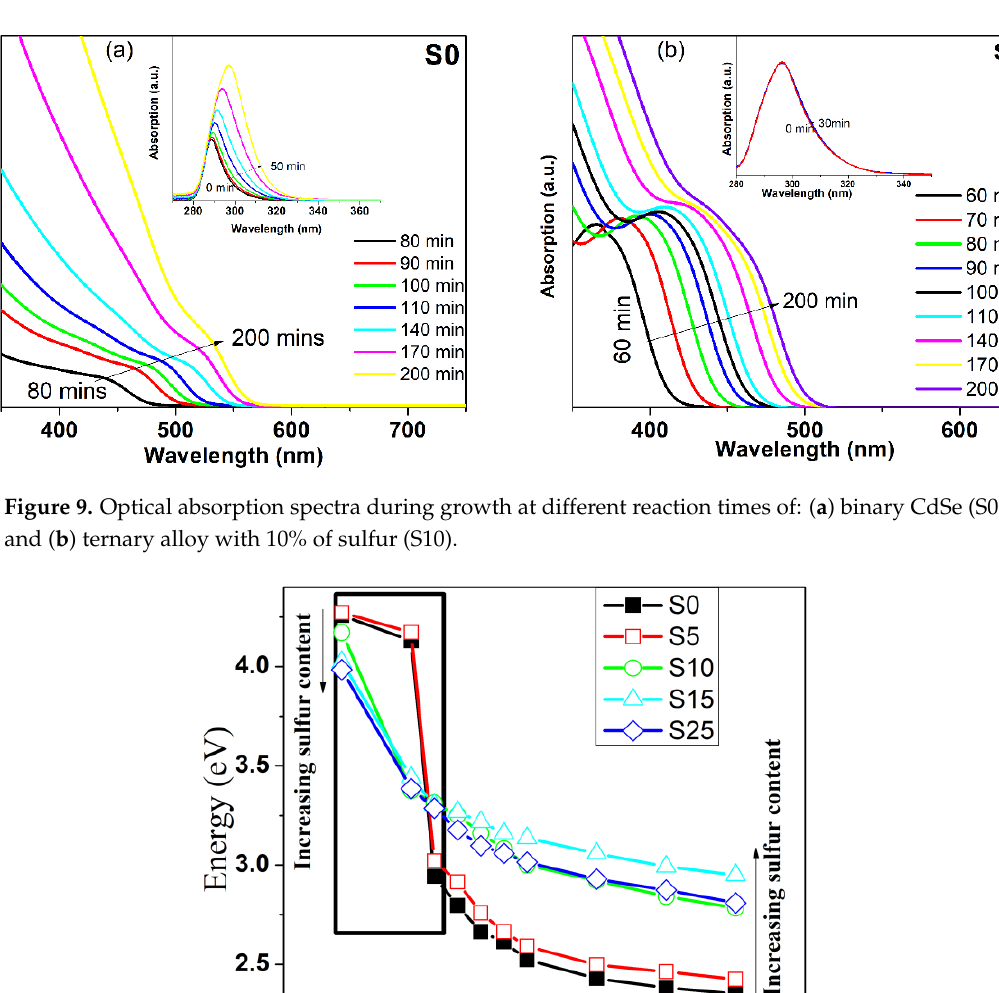
Figure 11. Absorption of CdSe (1− x ) S x with different concentrations of S of the precipitated samples ( a ) as a suspension in water ( b ) in a powder form.